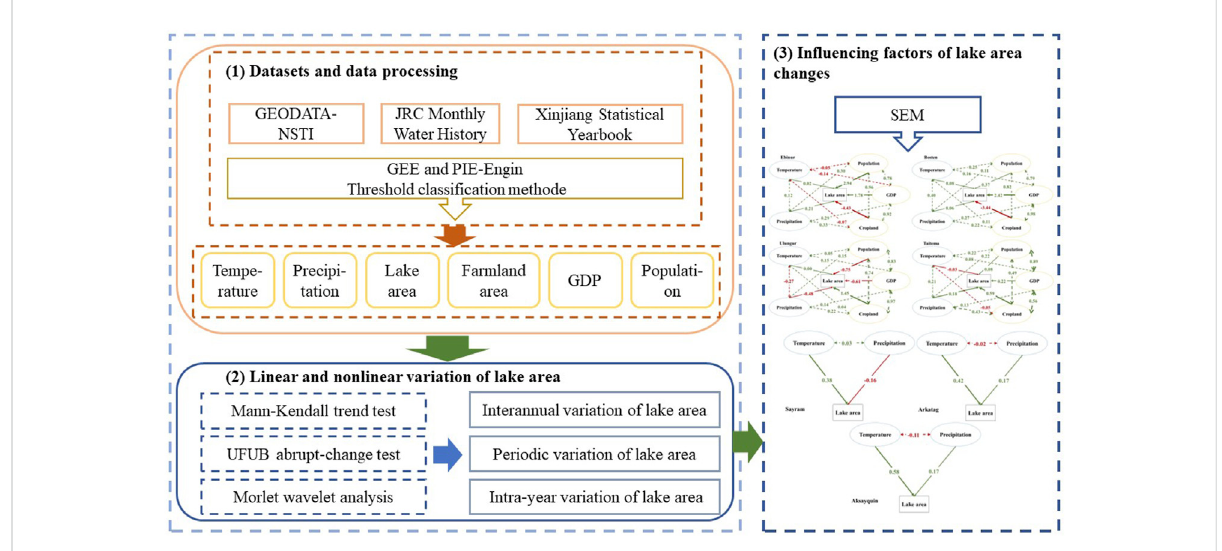
FIGURE 1 The overall framework of the